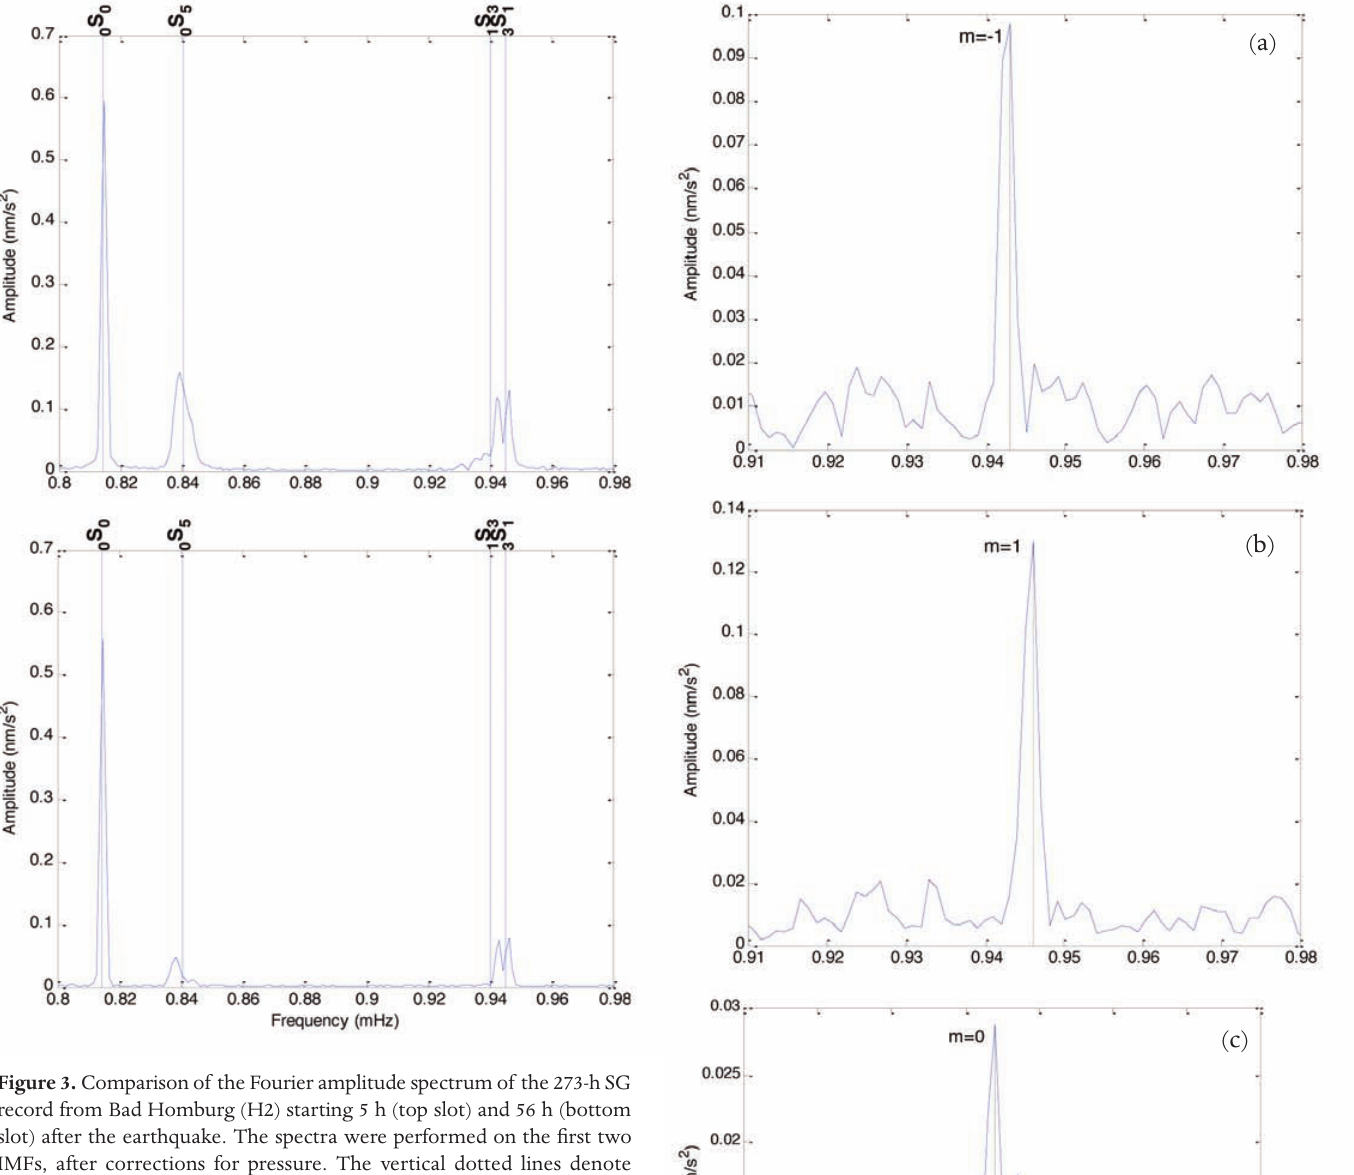
Figure 3. Comparison of the Fourier amplitude spectrum of the 273-h SG record from Bad Homburg (H2) starting 5 h (top slot) and 56 h (bottom slot) after the earthquake. The spectra were performed on the first two IMFs, after corrections for pressure. The vertical dotted lines denote degenerate frequencies for the model PREM.